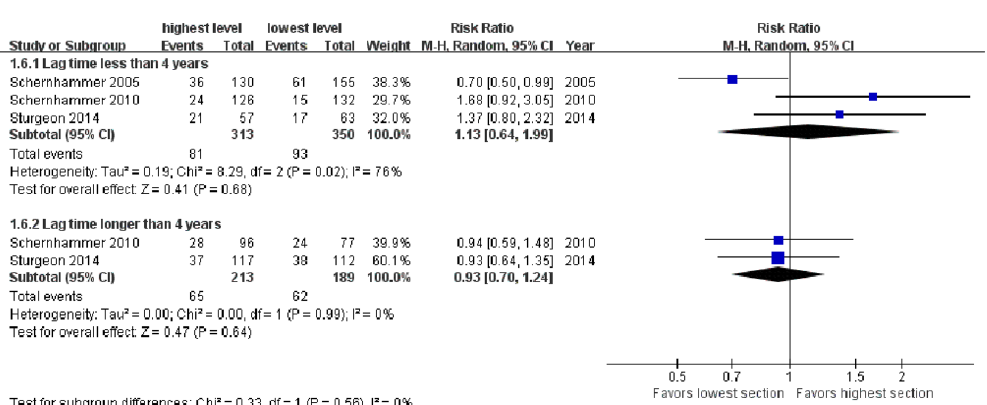
Figure 4. Forest plot for the association between urinary 6-sulfatoxymelatonin levels and risk of invasive (upper sub-figure) and in situ (lower sub-figure) breast tumors. There exists no significant association between 6-sulfatoxymelatonin level and risks of invasive or in situ breast cancer.